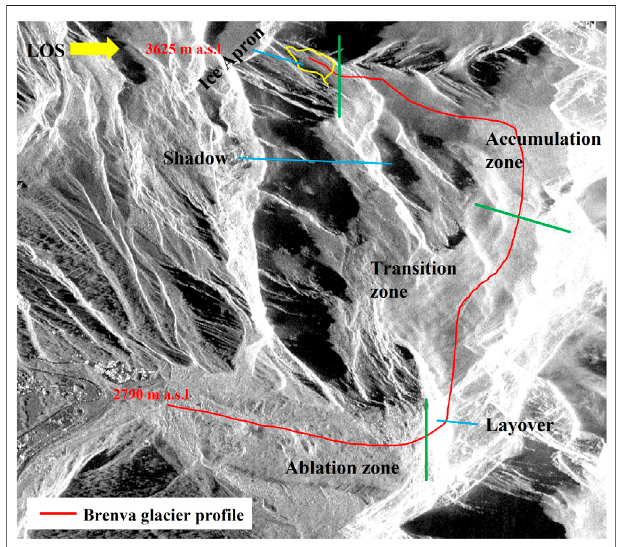
FIGURE 2 | Temporal mean of 28 PAZ descending images acquired in 2020. Glacier pro fi le along the Brenva glacier on the Italian side ofMont-Blanc massif (MBM) (red). The image shown is in the original RaDAR